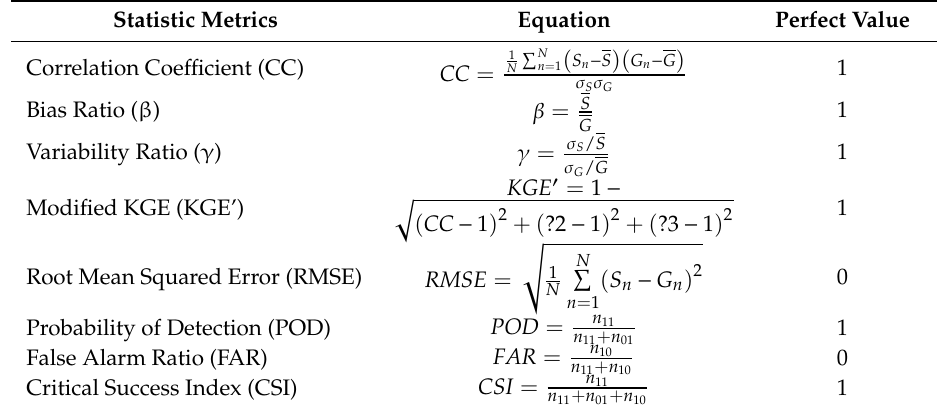
Table 2. List of statistic metrics used in the evaluation and comparison of satellite precipitation products. Statistic Metrics Equation Perfect